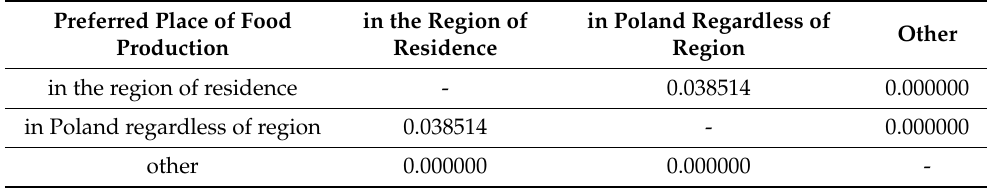
Table 5. Level of relationship with market—Dunn’s test